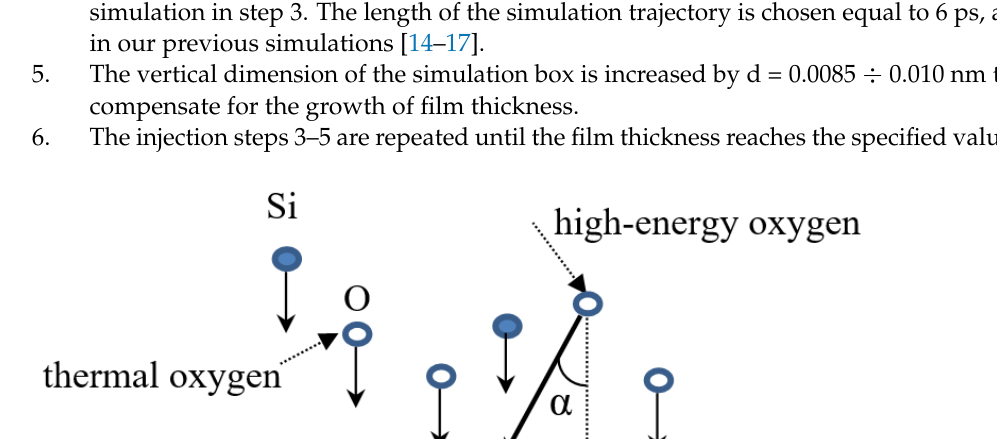
where q i(j) is the charge of the i ( j )-th atom, q O = − 0.5 q Si = − 0.65e, r ij is the interatomic distance, A SiO = 4.6·10 − 8 kJ·(nm) 12 /mol, A SiSi = A OO = 1.5·10 − 6 kJ·(nm) 12 /mol, B SiO = 4.2·10 − 3 kJ·(nm) 6 /mol, and B SiSi = B OO = 5·10 − 5 kJ·(nm) 6 /mol. The charge parameters of the oxygen and silicon atoms were initially chosen based on considerations arising from the Takada potential [19], and then the correctness of this choice was